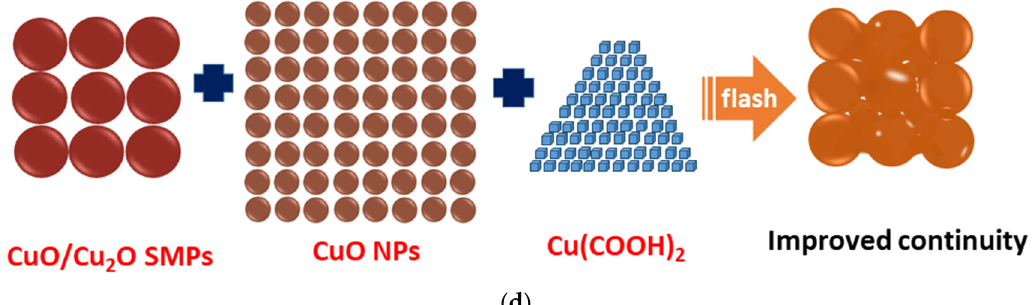
Figure 10. Schematics showing paste ingredients and obtained photonic-sintered structures: ( a ) SMPO only, ( b ) NPO only, ( c ) SMPO and NPO, and ( d ) SMPO, NPO, and copper formate.